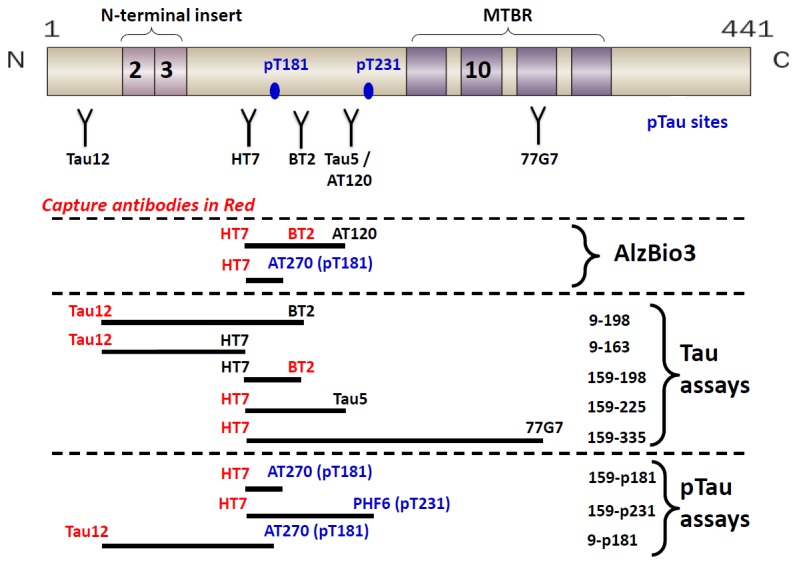
Tau and ptau ELISAs.Schematic of tau 441 protein with the approximate location of various linear epitope antibodies Tau12, HT7, BT2, Tau5, AT120 and 77G7 and phospho-site specific antibodies AT270 (p181) and PHF6 (p231) indicated; additional antibody epitope and clone information included in Table 1. Antibody combinations used for the different tau and ptau ELISAs are shown. For each assay, capture antibodies are highlighted in red, detection antibodies in black and the minimal tau region required (aa numbering based on tau 441) is indicated. Antibodies used in the INNOTEST/INNO-BIA AlzBio3 total tau and p181 tau assays are also shown for comparison.